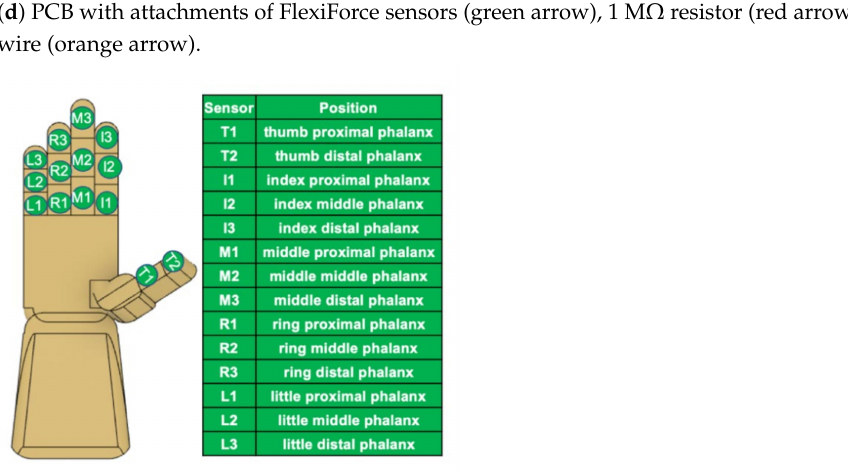
Figure 2. Force sensor positions. A total of 14 FlexiForce sensors were used on each digit and accordingly